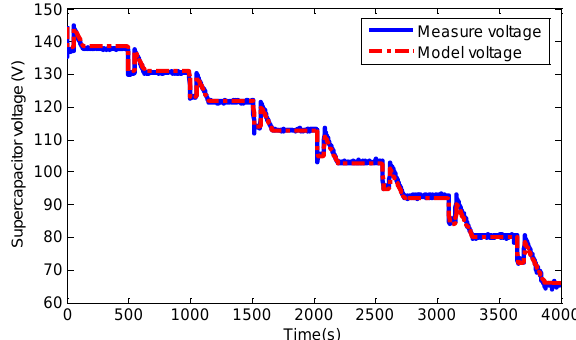
Figure 7. Voltage comparison curves of the supercapacitor.